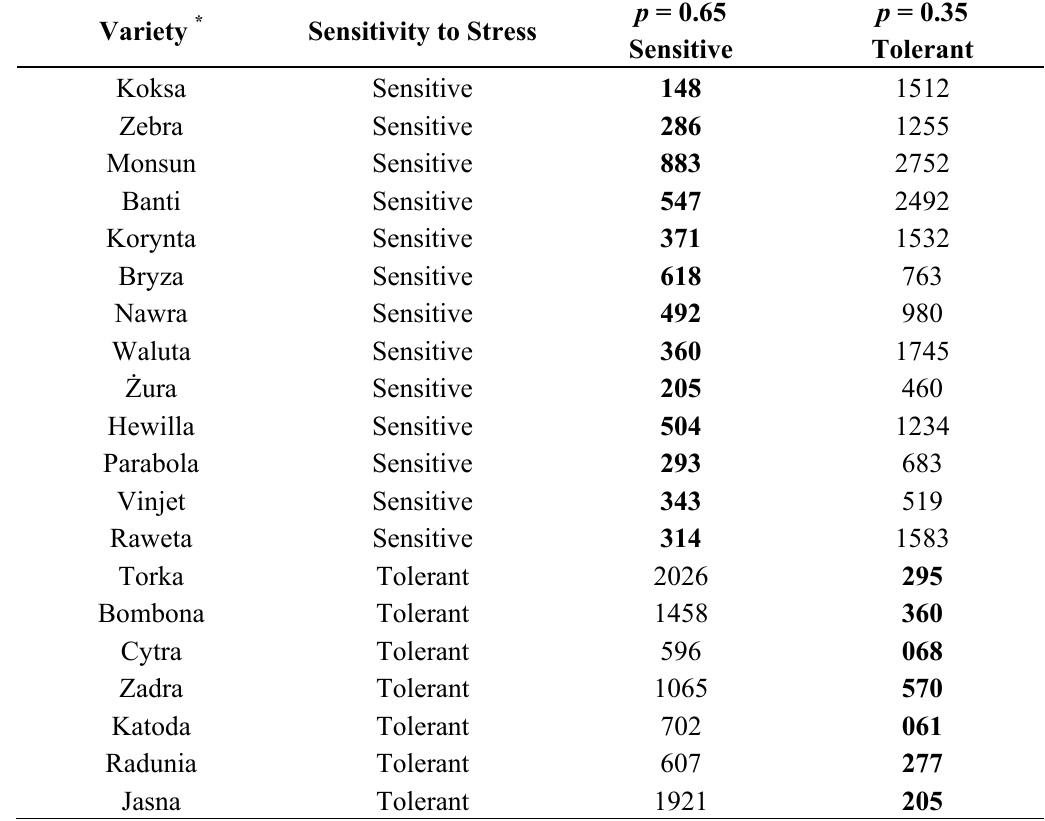
Table 7. Squares of Mahalanobis distance from